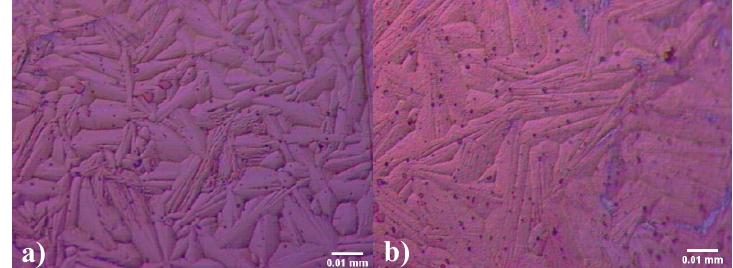
Figure 1. ( a ) Grain Outlines of Sample “A”; ( b ) Grain contours of sample “B”. 50× magnification.